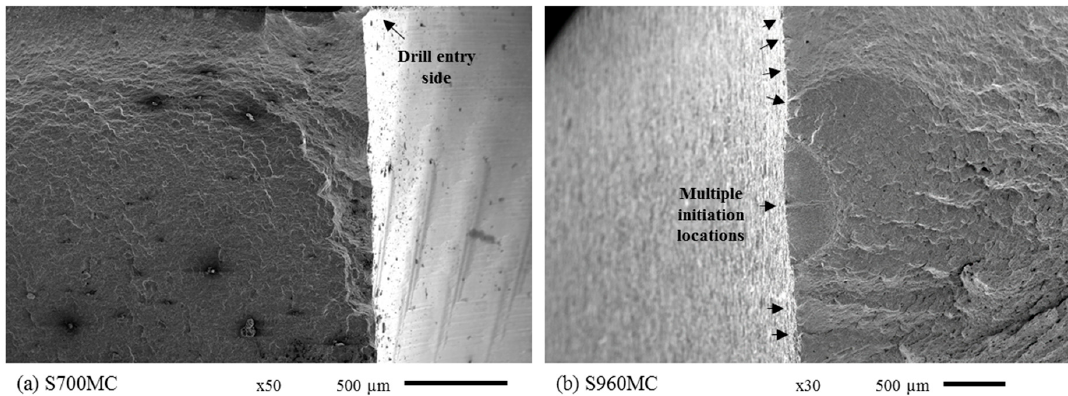
Figure 19. Fracture details of ( a ) entry drill chip (S760MC) and ( b ) waterjet-cut mid-hole surface (S960MC).